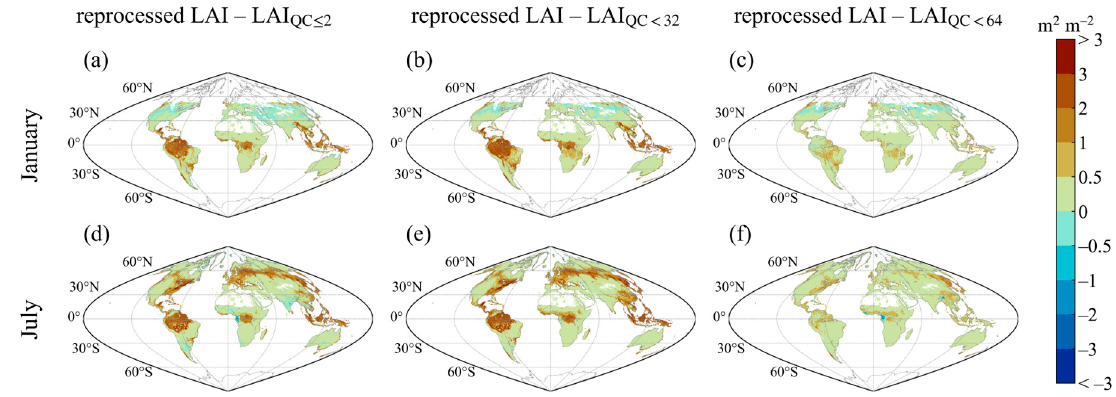
Figure 10. Difference between reprocessed MODIS LAI and MCD15A2H C6.1 LAI constrained